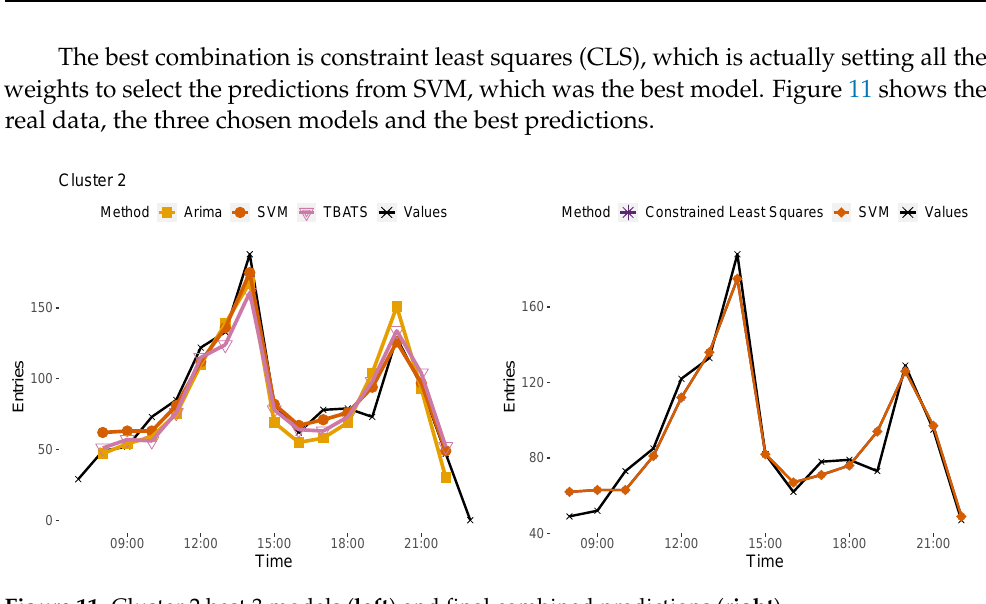
Figure 11. Cluster 2 best 3 models ( left ) and final combined predictions ( right